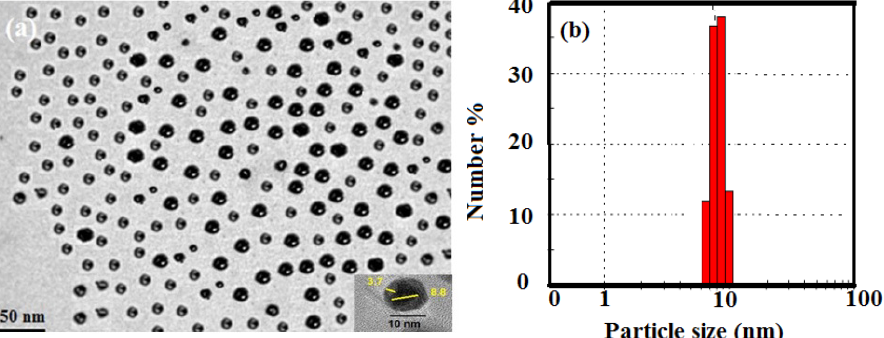
Figure 4. TEM micrograph ( a ) and histogram ( b ) of the as-prepared magnetite nanocrystals. The y -axis of the histogram represents the number of particles.